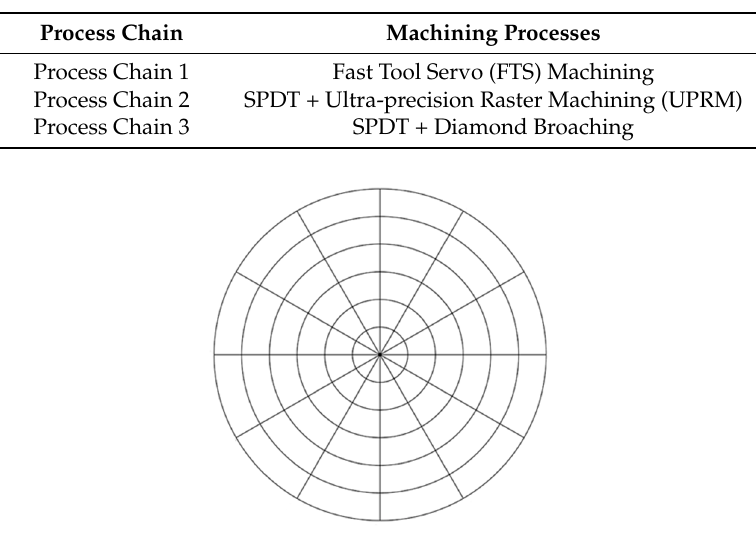
Figure 2. Design of machining process 3 (MPC3).